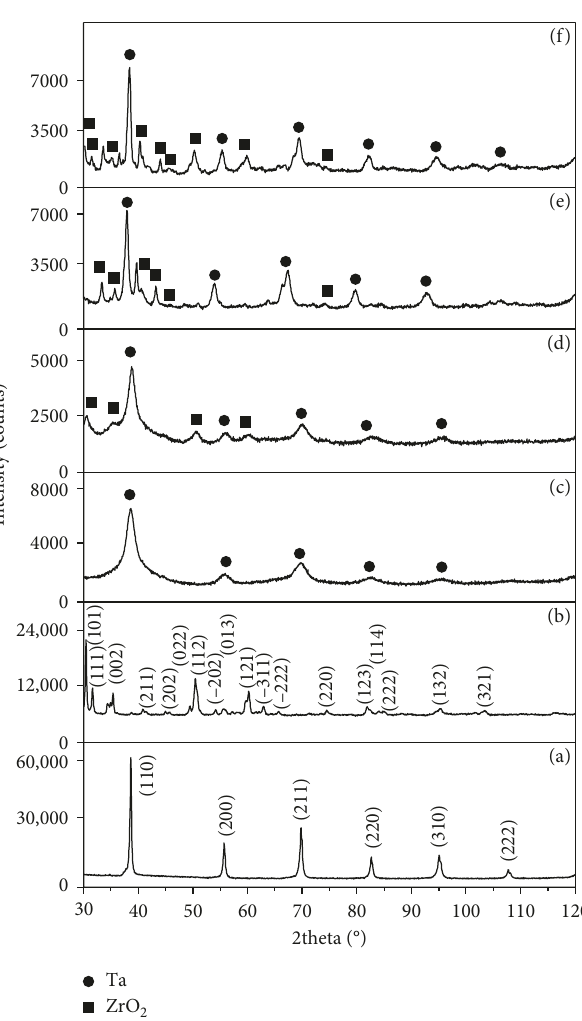
Figure 1: XRD of the pure Ta (a) and Y 2 O 3 (b) powders; Ta-5Y 2 O 3 Figure 2: XRD of the pure Ta (a) and ZrO 2 (b) powders; Ta-5ZrO 2 (c) and Ta-40Y 2 O 3 (d) nanocomposites’ powder mixture after (c) and Ta-40ZrO 2 (d) nanocomposites’ powder mixture after mechanical alloying; and Ta-5Y 2 O 3 (e) and Ta-40Y 2 O 3 (f) bulk mechanical alloying; and Ta-5ZrO 2 (e) and Ta-40ZrO 2 (f) bulk nanocomposites after nanocomposites after consolidation.